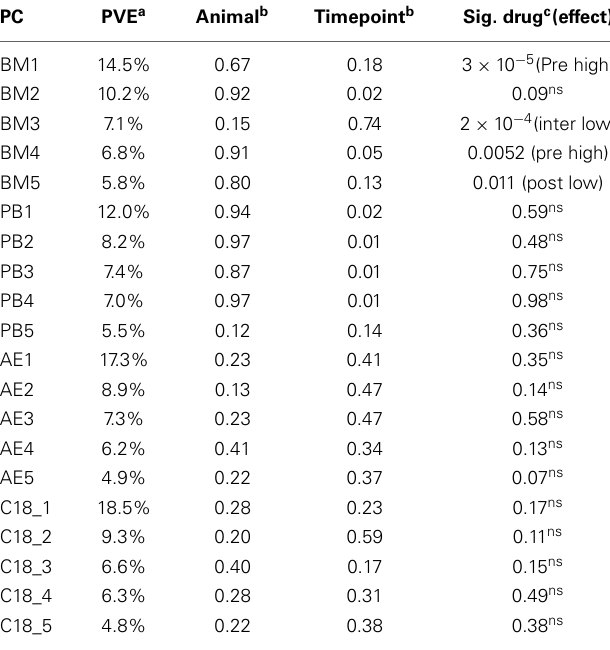
Table 1 | Principle components of